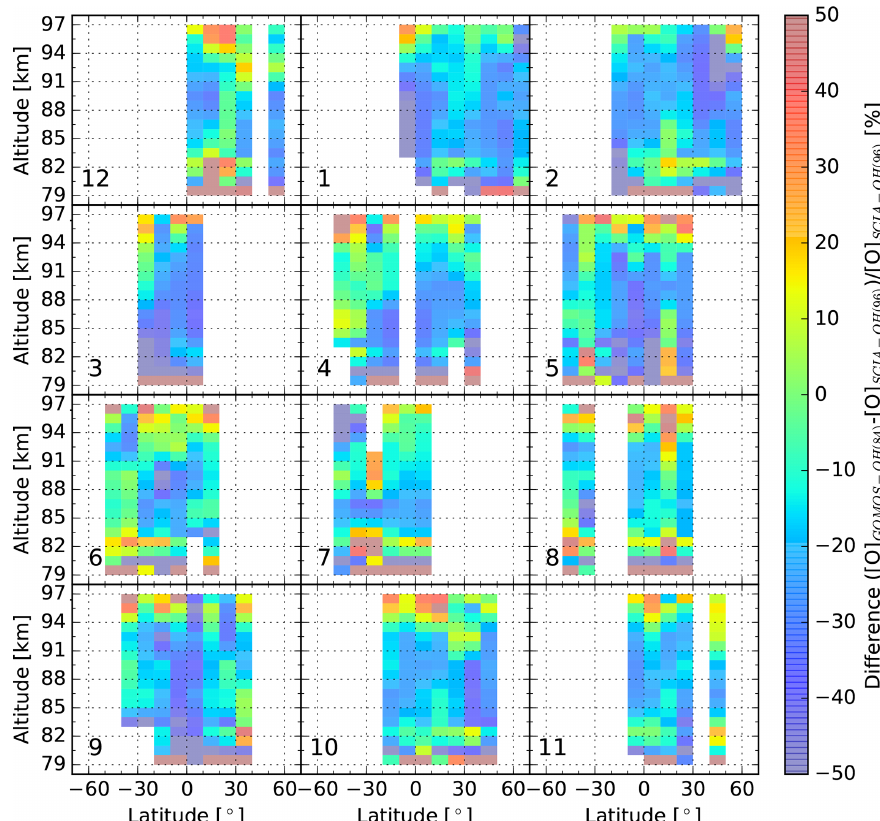
Figure 14. Latitude–altitude distribution of percentage differences between zonal mean atomic oxygen densities derived from GOMOS OH(8–4) and SCIAMACHY OH(9–6) airglow emissions for 2007. The SCIAMACHY OH(9–6) are taken from Zhu and Kaufmann (2018). This figure is plotted in a similar way to Fig. 13. Negative numbers indicate that SCIAMACHY OH(9–6) atomic oxygen abundances are larger than the GOMOS OH(8–4)